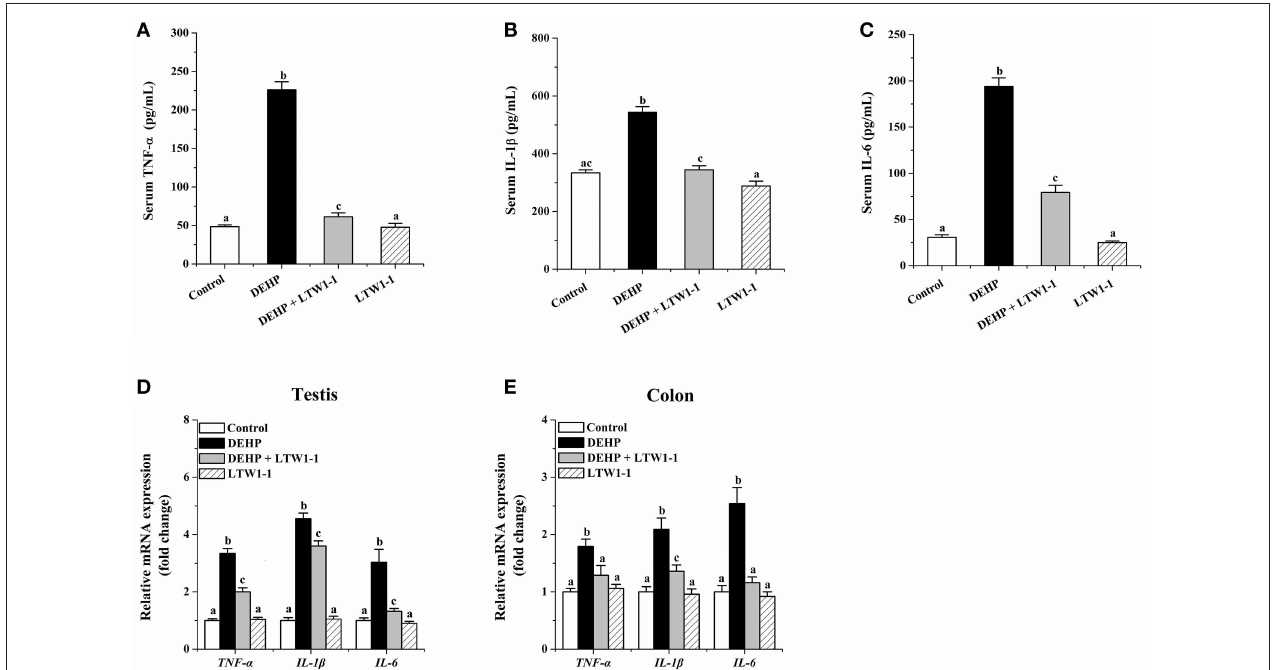
FIGURE 3 | Effects of L. plantarum TW1-1 treatment on inflammatory factors in the serum, testes and colon in DEHP-exposed mice. (A) Serum TNF- α level. (B) Serum IL-1 β level. (C) Serum IL-6 level. (D) Relative mRNA expression of TNF- α , IL-1 β , and IL-6 in the colon. (E) Relative mRNA expression of TNF- α , IL-1 β , and IL-6 in the testis. The levels of TNF- α , IL-1 β , and IL-6 were detected by ELISA. Gene expression levels of these cytokines were analyzed by RT-qPCR. The data are expressed as mean ± S.E.M. ( n = 7–8), different letters represent significant differences between groups by Tukey’s test ( P < 0.05).